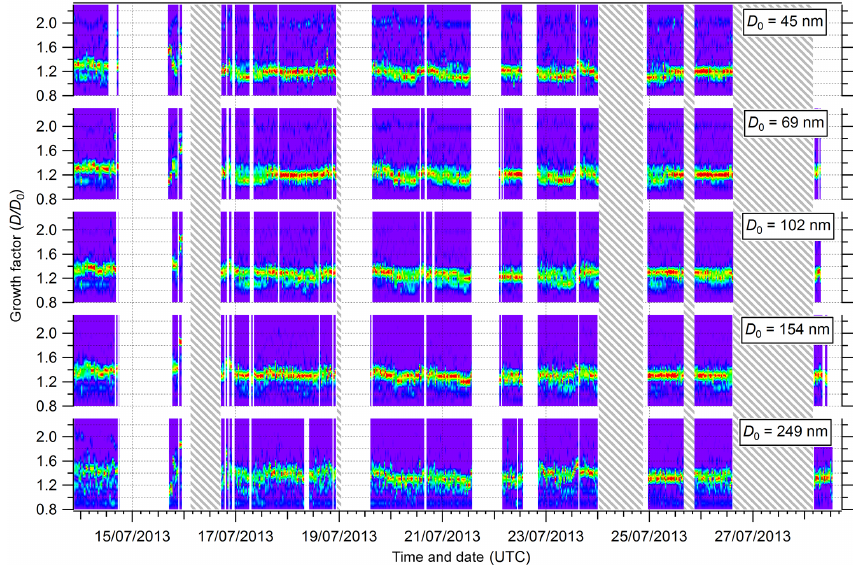
Figure 7. The time series of normalized RH-corrected (to 90%) growth factor distributions derived from HTDMA measurements, for all five dry diameters. Shaded areas represent pollution episodes removed from the data. Any other gaps are due to instrument downtime and